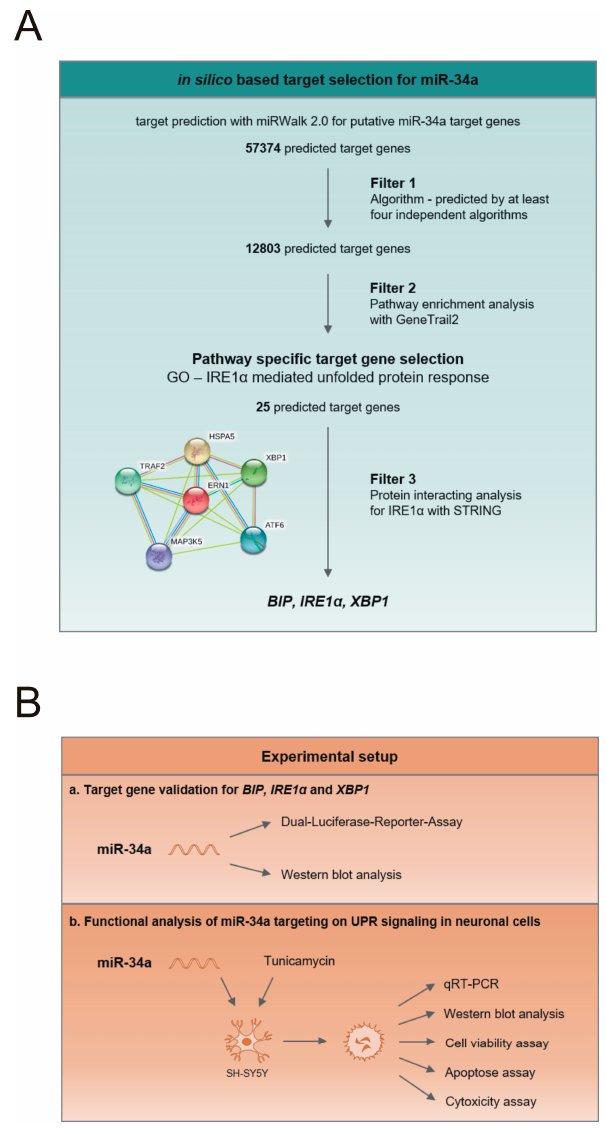
Figure 1. Paper workflow. A: in-silico-based target selection for miR-34a, including protein interaction analysis by STRING. Putative miR-34a target genes were predicted by an in-silico-based approach and computationally filtered for IRE1 α -mediated unfolded protein response resulting in the three target genes BIP , IRE1 α and XBP1 . STRING analysis: magenta lines: experimentally determined protein interactions; blue lines: known interactions from curated databases; yellow lines: text mining. B: experimental setup. The target genes BIP , IRE1 α and XBP1 for miR-34a-5p were experimentally validated, and the effect of miR-34a targeting was analyzed by functional analysis.